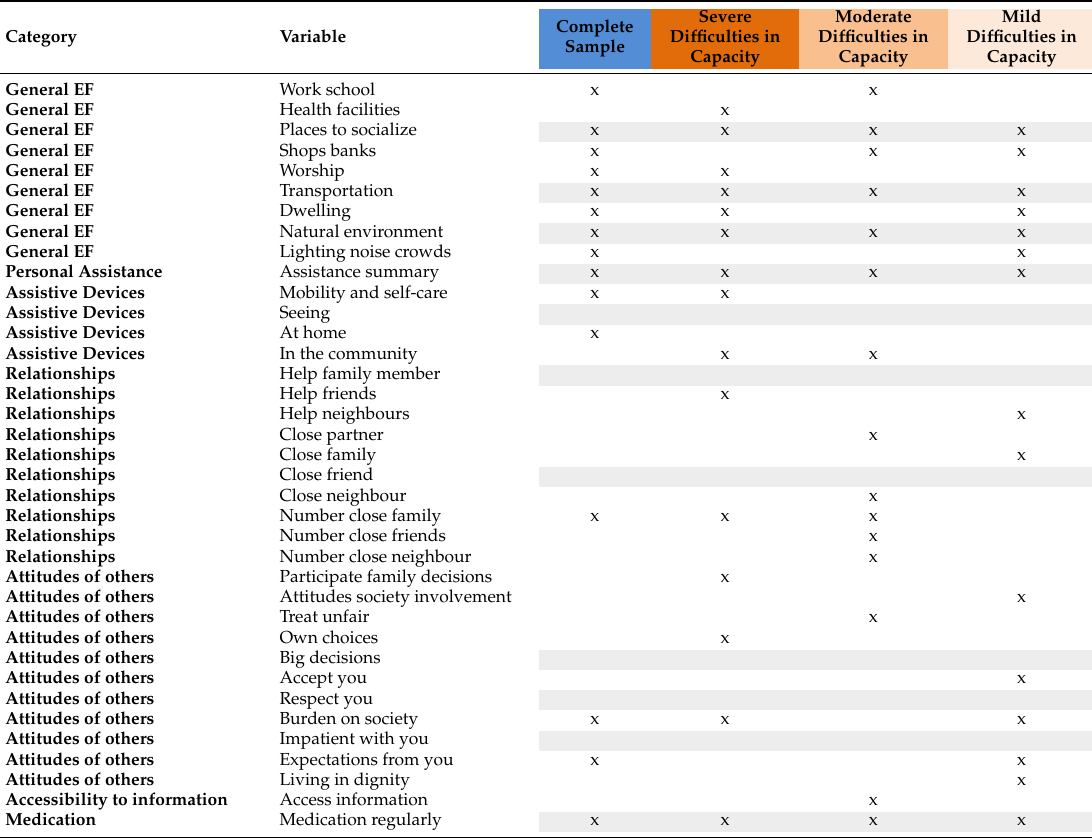
Table 3. Most relevant environmental factors (EFs) across all levels of disability and the complete